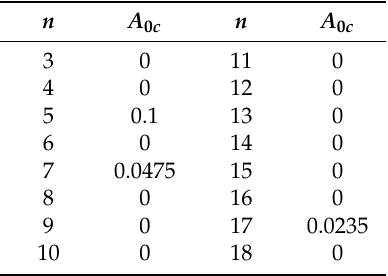
Table 2. The amplitude of baseband harmonics in the output line